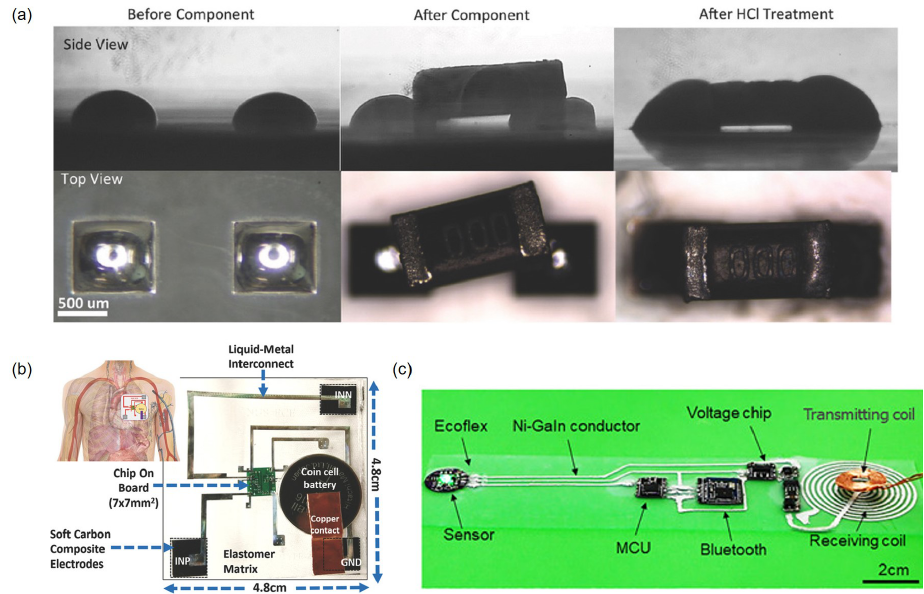
Figure 14. ( a ) Liquid metal is used as a solder paste for surface mount passive components. The components misaligned on liquid metal pads are aligned by HCl treatment. Reproduced with permission from [59]; published by John Wiley and Sons, 2018. ( b ) Liquid metal interconnects are used for the stretchable electrocardiogram patch. Reproduced with permission from [84]; published by John Wiley and Sons, 2019. ( c ) An overview of the pulse measurement circuit. Solid-state electronic parts are connected with liquid metal interconnections. Reproduced with permission from [82]; published by John Wiley and Sons, 2018.